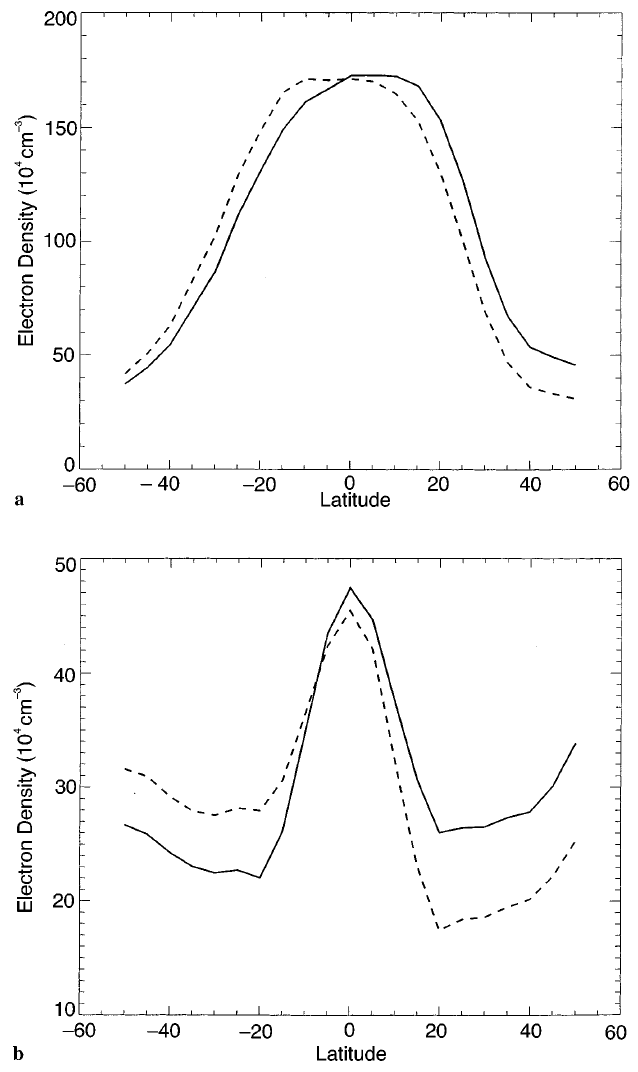
Fig. 5a. Latitude variations of the modelled electron density at March ( solid curve ) and September ( dashed curve ) during daytime. b Same as a except